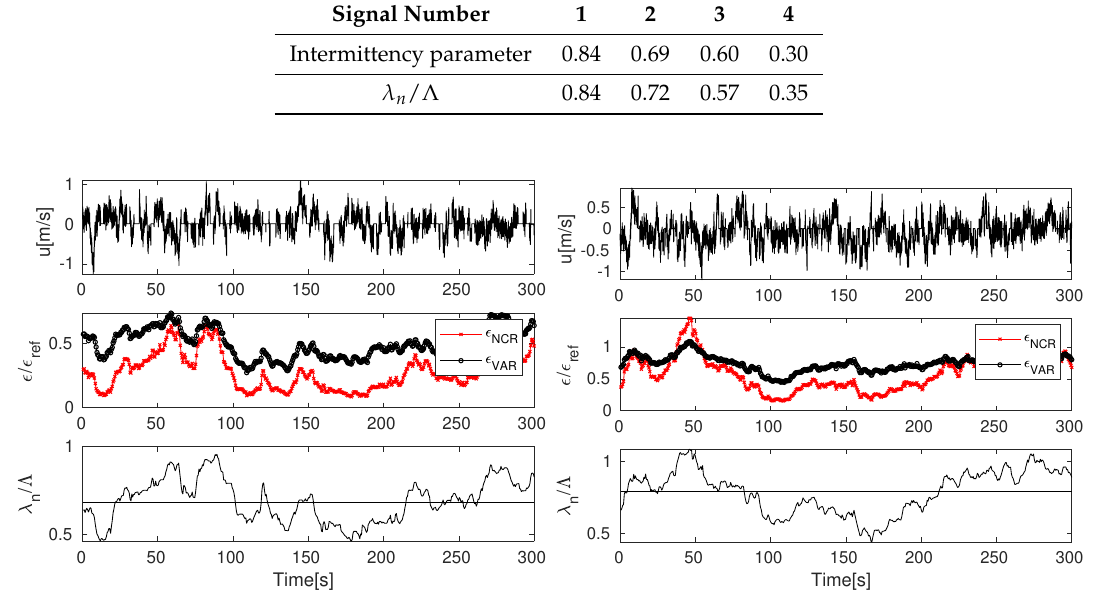
Figure 27. Top plots: Part of an artificial signal, middle plots: (cid:101) estimates, bottom plots: Taylor-to Liepmann scale ratio. Left column: signal with the intermittency parameter 0.69, right column: signal with the intermittency parameter